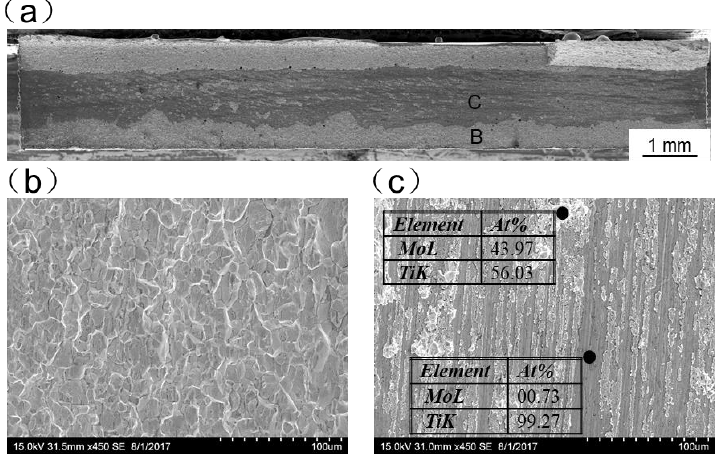
Figure 17. SEM images of tensile fracture when the offset is +0.75mm ( a ) overall morphology; ( b , c ) Magnified images of region B and C in panel ( a ).